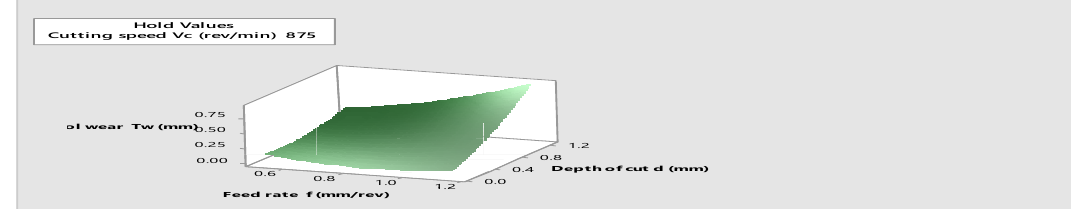
Figure 17: 3D surface graph for tool wear with